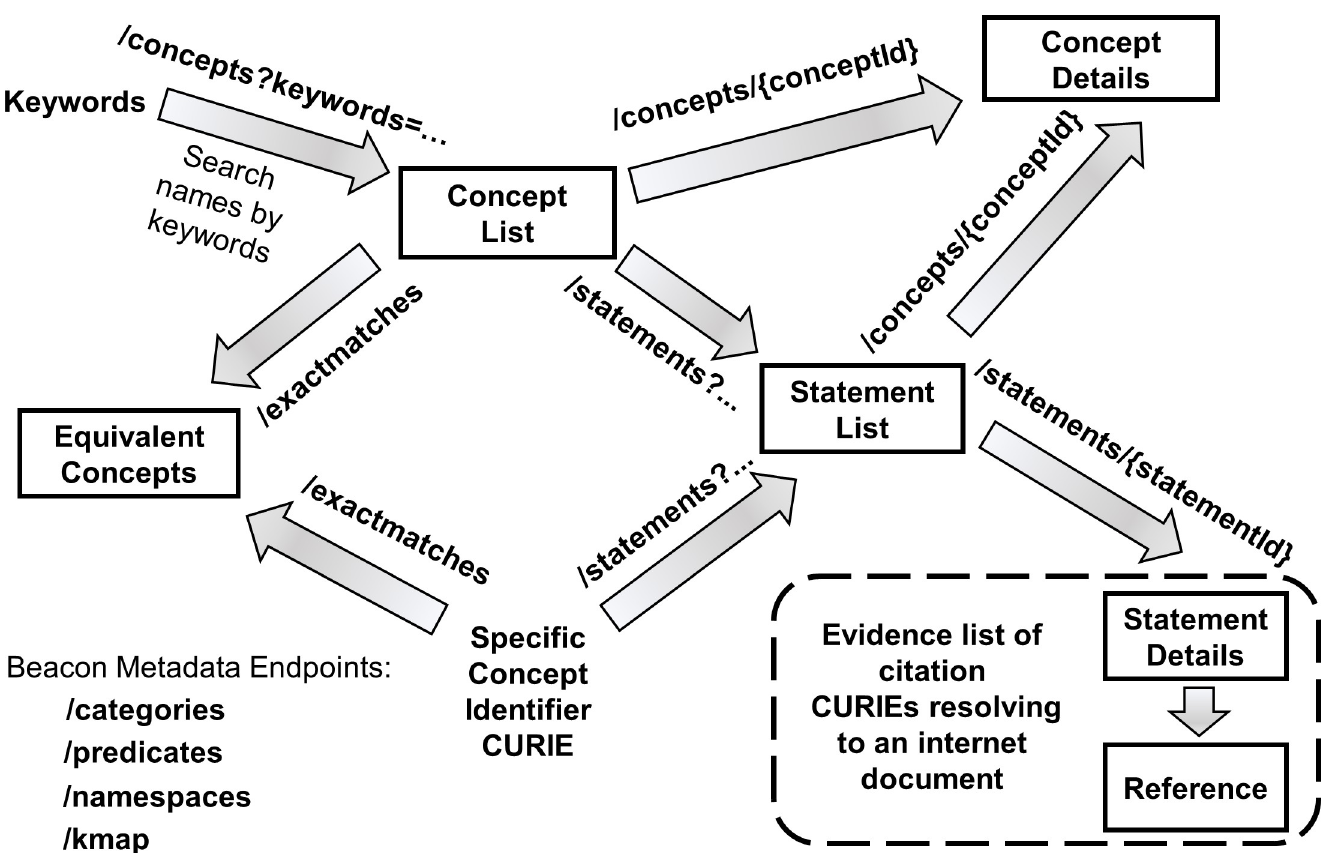
Fig 1. Knowledge Beacon API. General step-by-step flowchart illustrating the sequential invocation of Beacon web service endpoints, with data flows as indicated. Also enumerated at the bottom lefthand corner of the diagram is the set of metadata endpoints that report semantic terms and namespaces used by the Beacon in the annotation of